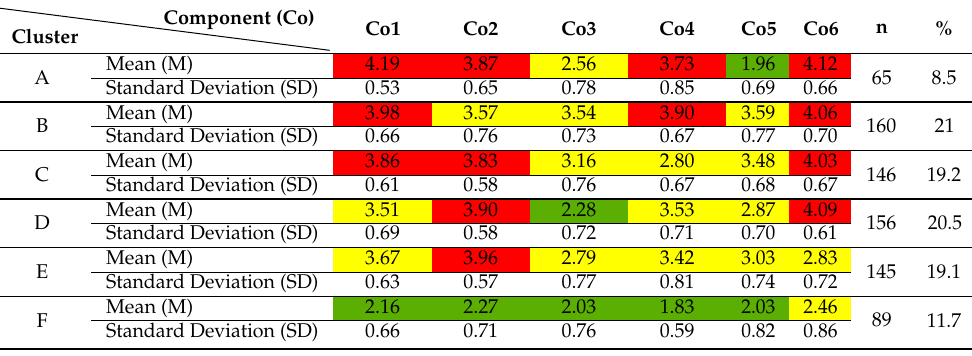
, 2.34–3.67 (Moderate)